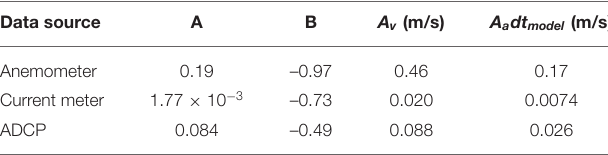
TABLE 1 | Amplitude of energy in unresolved timescales and associated power law